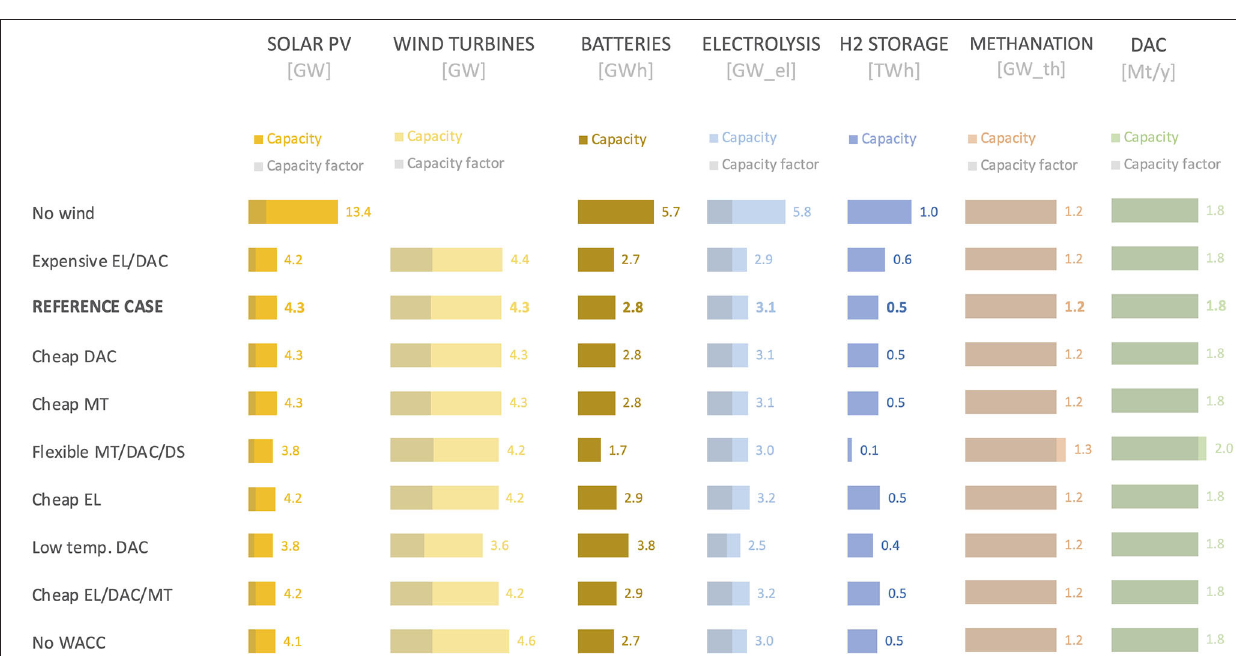
FIGURE 8 | Breakdown of synthetic methane costs obtained under various techno-economic assumptions.